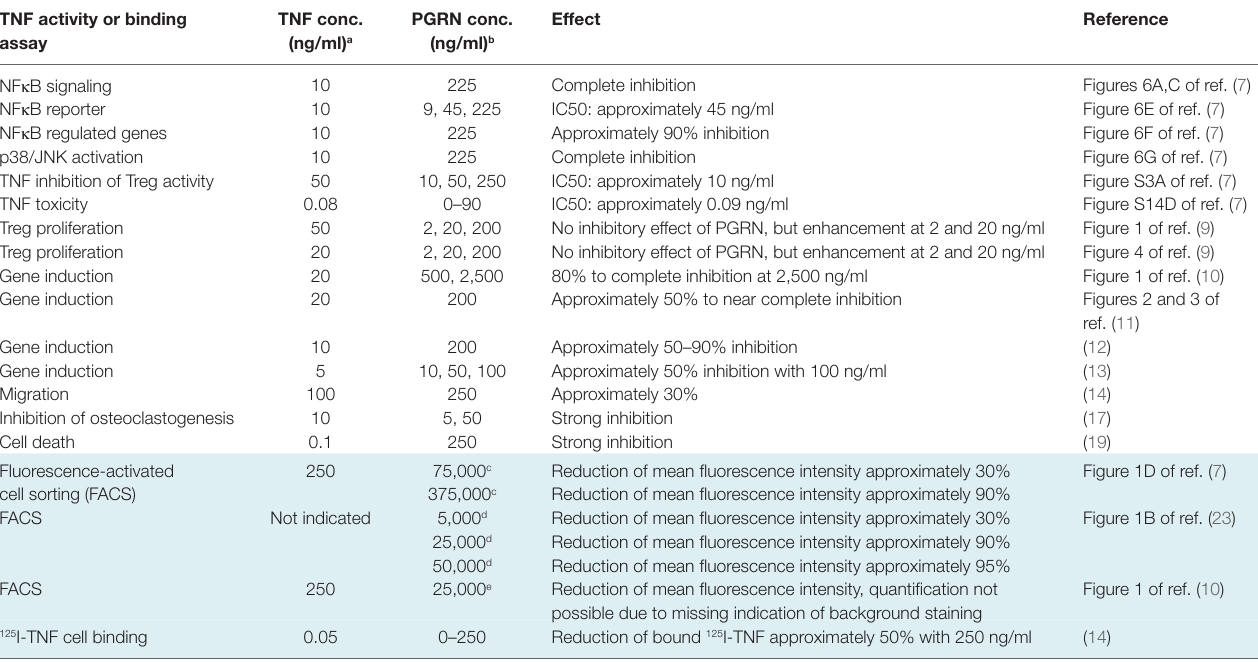
TaBle 2 | Inhibitory effects of progranulin (PGRN) on tumor necrosis factor (TNF) activity and TNF receptor binding of TNF in intact